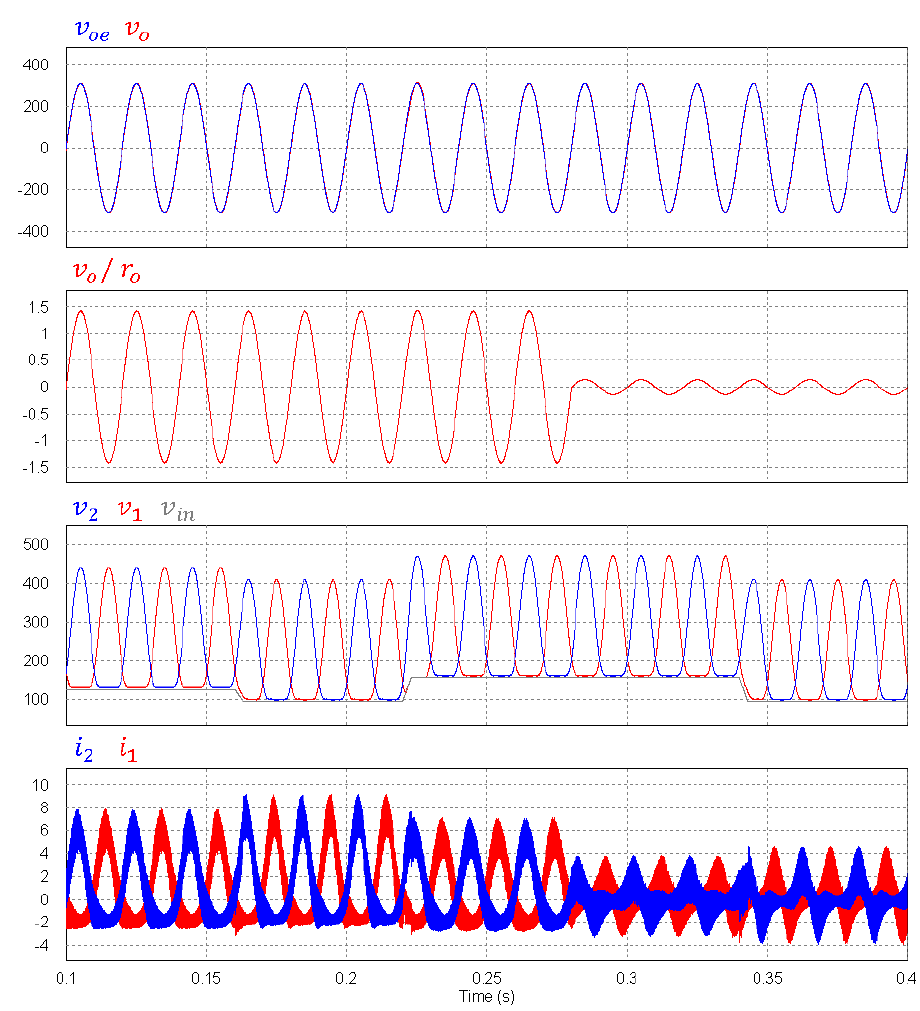
Figure 13. Simulated waveforms during experiment 2 using the proposed DS-SMC. Figure 12. Simulated waveforms during experiment 2 using the proposed